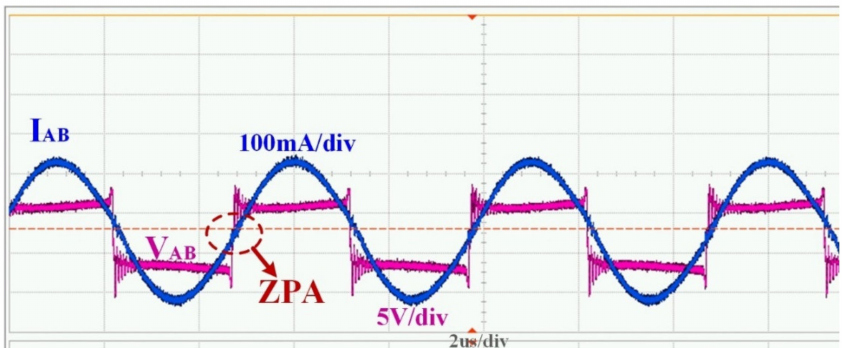
Figure 34. Transmitter coil voltage V L1 and receiving coil voltage V L2 .